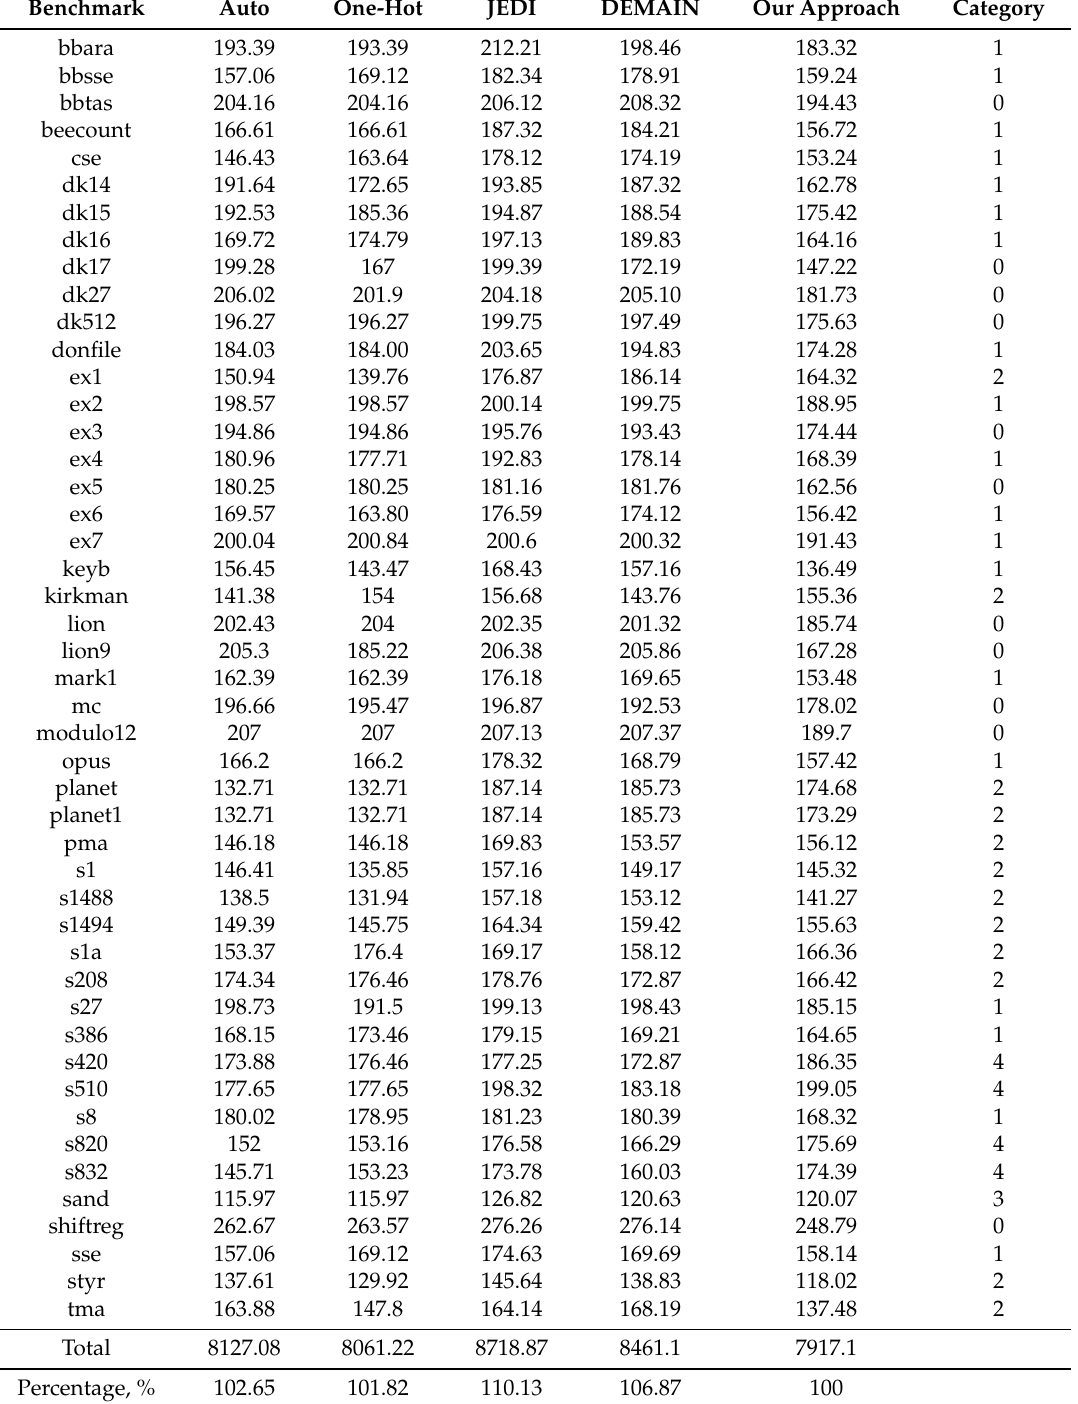
Table 6. Experimental results (the operating frequency,